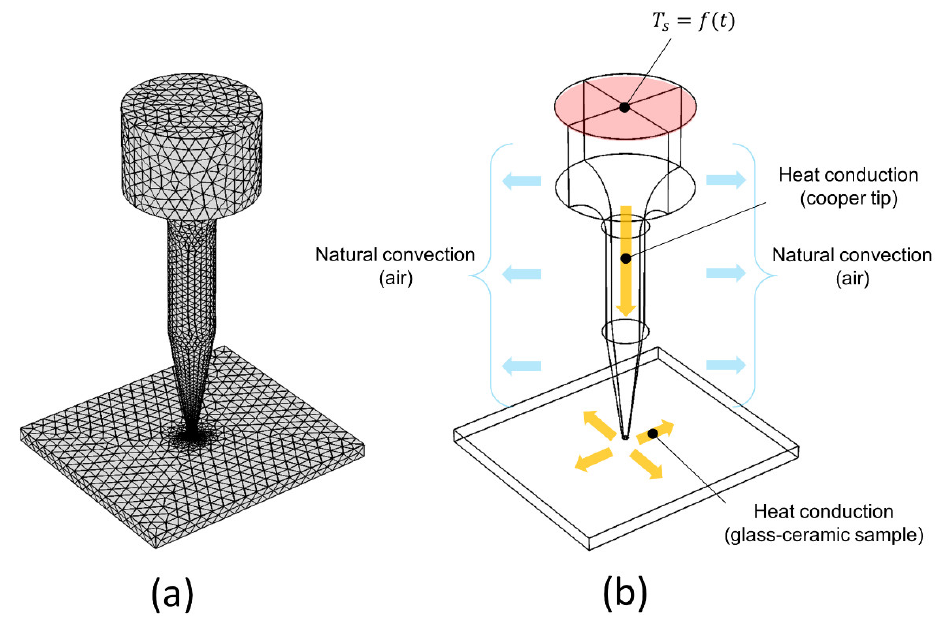
Figure 2. ( a ) 3D heated tip and sample model discretized by finite elements. ( b ) Schematic of the heat-transfer mechanisms.